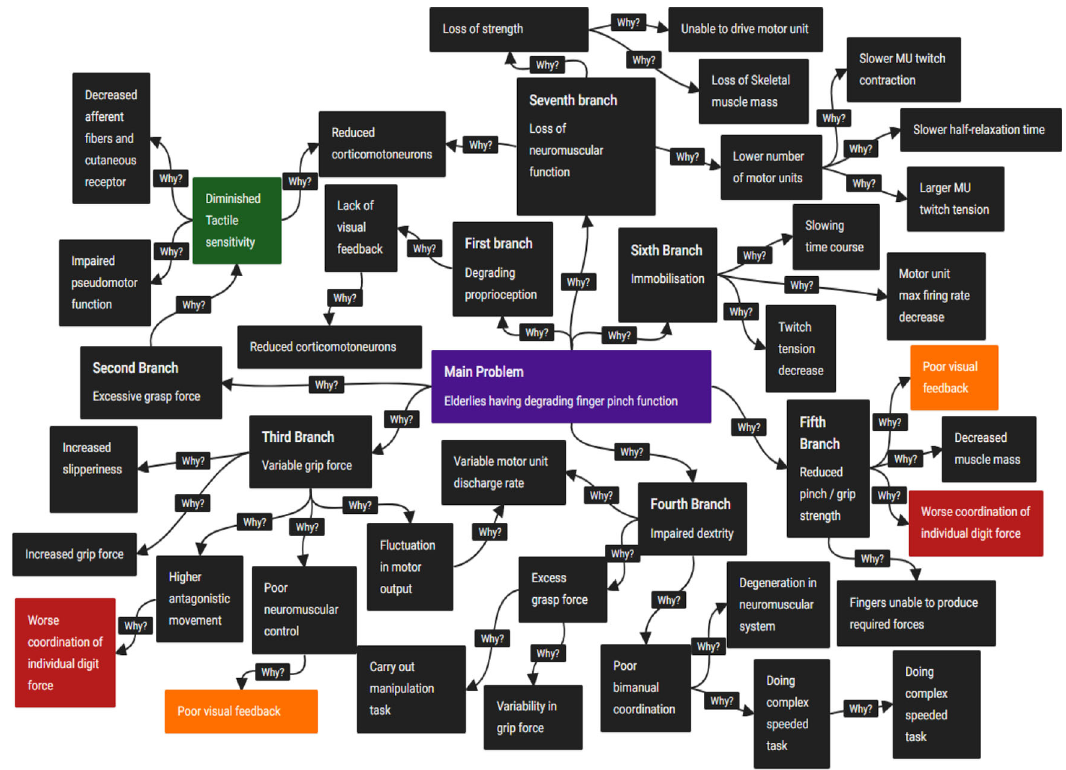
Figure 3. Cause-and-Effect Chain analysis